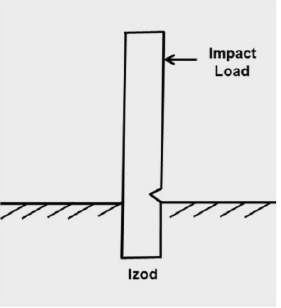
Figure 2. Schematic diagram of Izod Impact test.